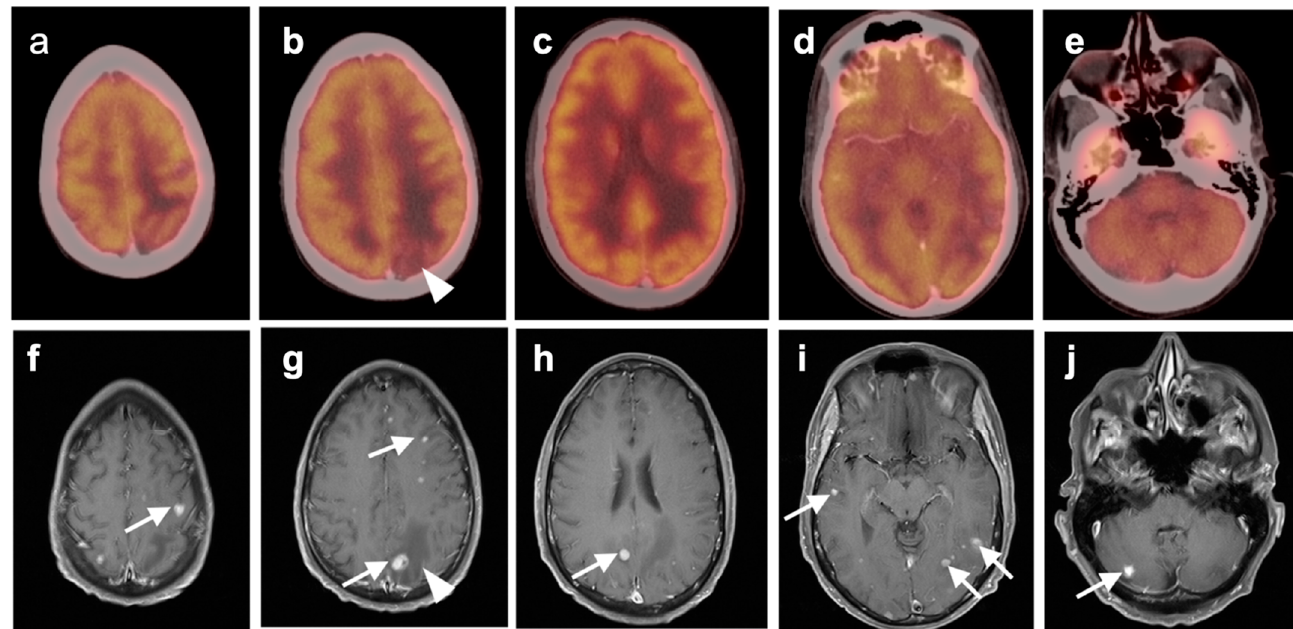
Figure 43. Brain metastases, isometabolic to normal brain cortex (melanoma). ( a ‐ e ) Incremental axial FDG PET ‐ CT images demonstrate some hypometabolism in areas of edema (white arrowhead) but multiple melanoma metastases to the brain are not resolved as having metabolic activity greater than that of normal brain parenchyma; ( f ‐ k ) Incremental axial Gd ‐ enhanced T1 MRI images demonstrate multiple enhancing brain nodules which were due to metastatic melanoma (white arrows).